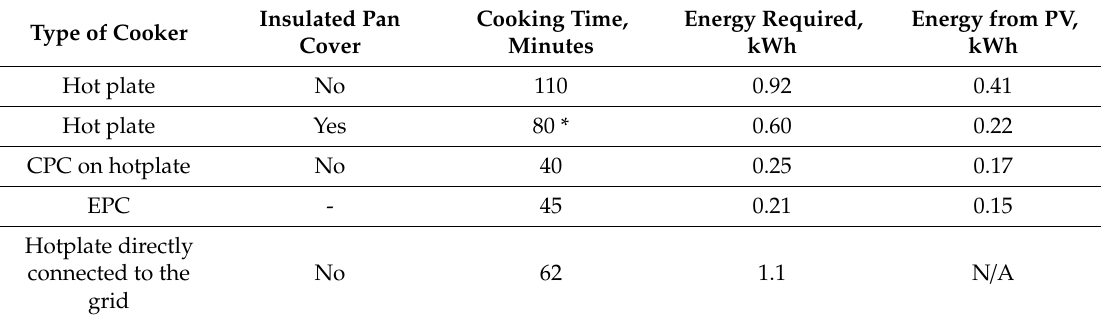
Table 6. Energy data for cooking chickpeas.